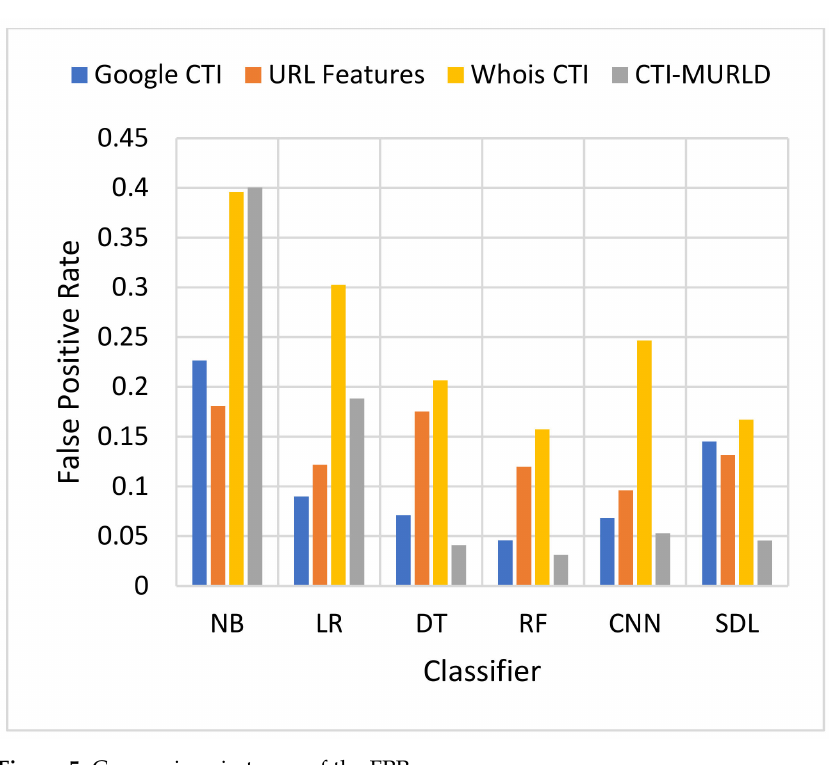
Figure 5. Comparison in terms of the FPR.